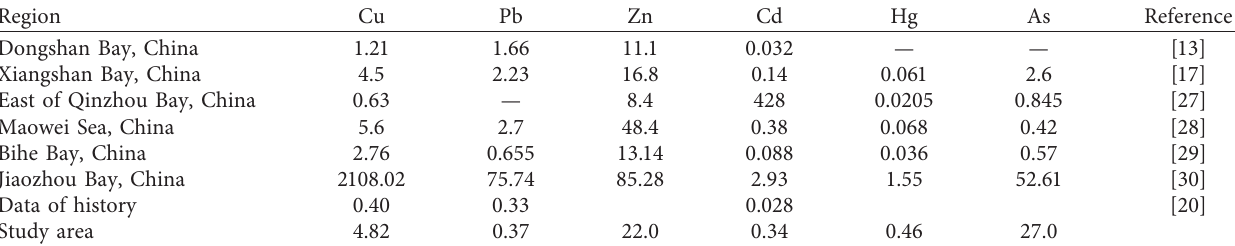
Table 4: Concentrations of heavy metals in seawater ( µ g/l) in the present study compared to published data for other locations in China. Region Cu Pb